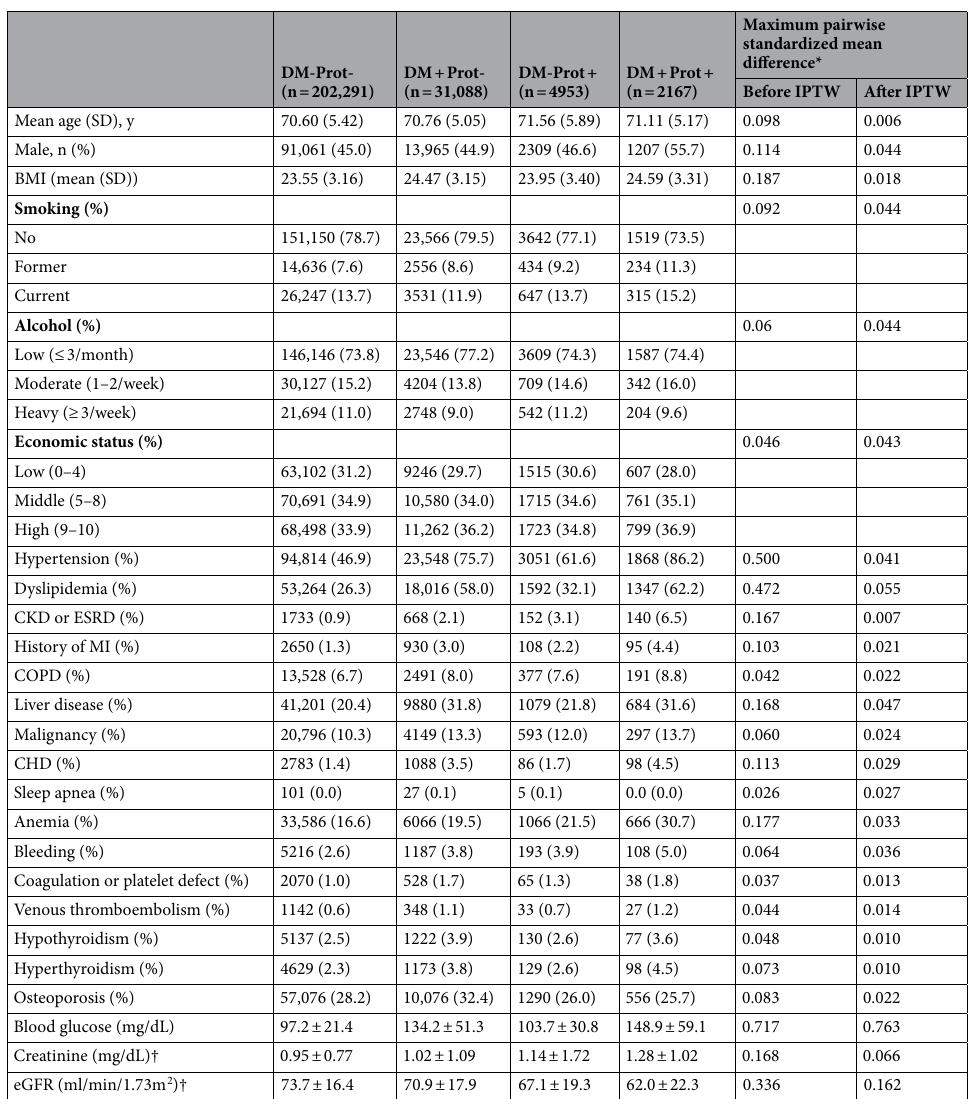
Table 1. Baseline characteristics. Values are expressed in n (%), mean ± SD. BMI body mass index, CHD coronary heart disease, CKD chronic kidney disease, COPD chronic obstructive pulmonary disease, eGFR estimated glomerular filtration rate, ESRD end-stage renal disease, IPTW inverse probability of treatment weighting, MI myocardial infarction, SD standard deviation. *Proposed cut offs for acceptable standardized differences ranged from 0.1 to 0.25. † Creatinine and eGFR were available in 19.7% of study population (N =